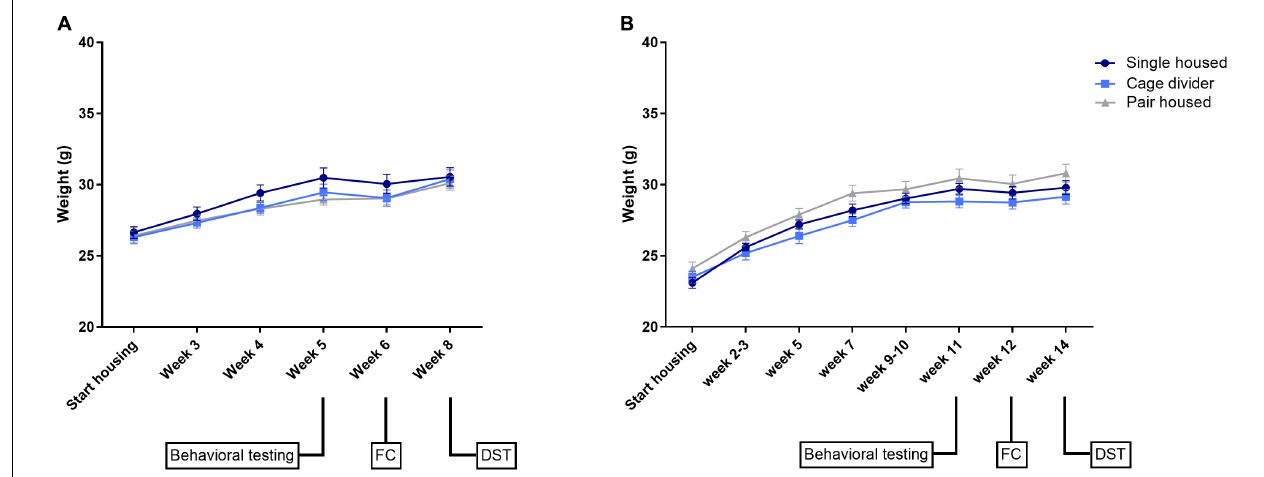
FIGURE 2 | Absolute body weights of mice that are single housed, pair housed and pair housed with a cage divider. (A) Absolute body weights in experiment 1. (B) Absolute body weights in experiment 2. Data are presented as mean ± SEM. n = 10 mice/housing condition. Statistical analysis: Repeated measures Two-way ANOVA. FC, fear conditioning; DST, dexamethasone suppression